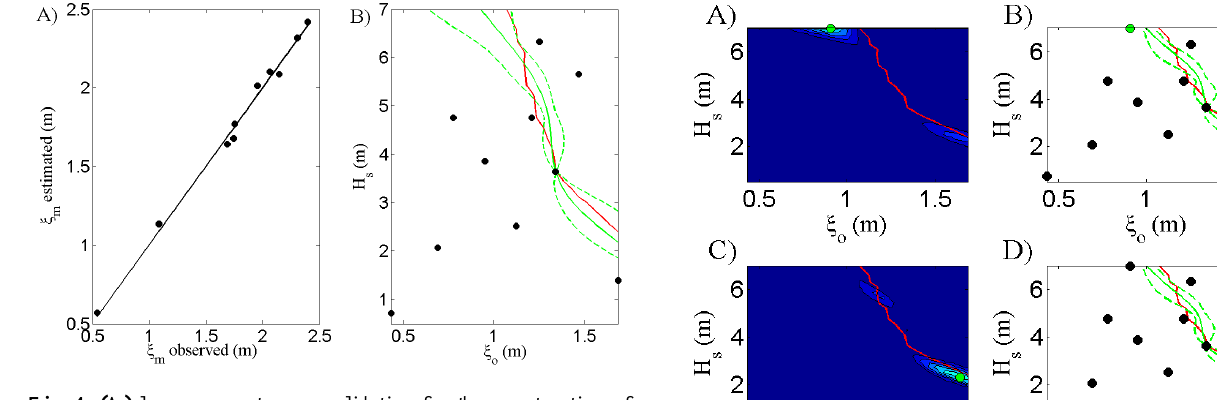
Figure 4. (A) leave-one-out cross-validation for the construction of the initial kriging model; black dots are the water level estimations. (B) Best estimate of 0 c in the { ξ o ; H s } domain associated with ξ c =2.15m (green solid line) using a kriging model constructed with 10 training data (black dots) selected randomly from a LHS technique. The associated pair of contours at confidence level 95% (defined as the kriging mean (Eq. 2) ± twice the square root of the variance (Eq. 3)) is represented by dashed green lines. The reference contour (estimated using computation grid architecture) is represented by a red solid line.